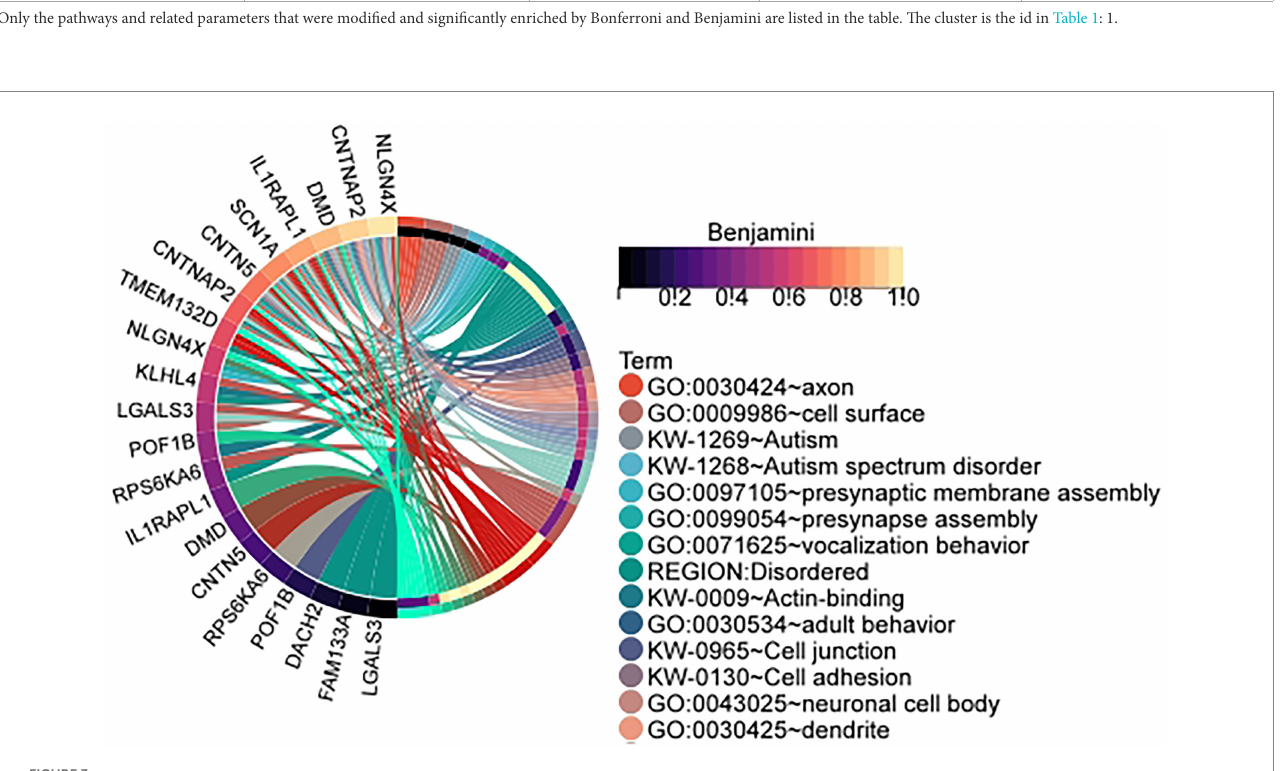
FIGURE 3 Enrichment circle plot of genes in clusters identified by our method in the male infertility data set. The cluster is the id in Table 1: 1. (Visualization of the relationship between genes and enrichment